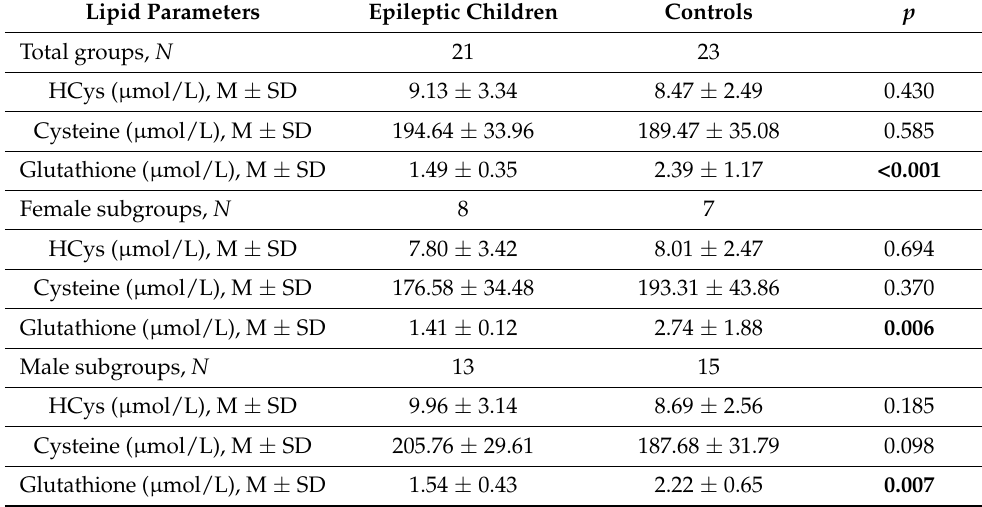
Table 4. Levels of selected aminothiols (HCys, cysteine and glutathione) in total groups and sex subgroups. Lipid